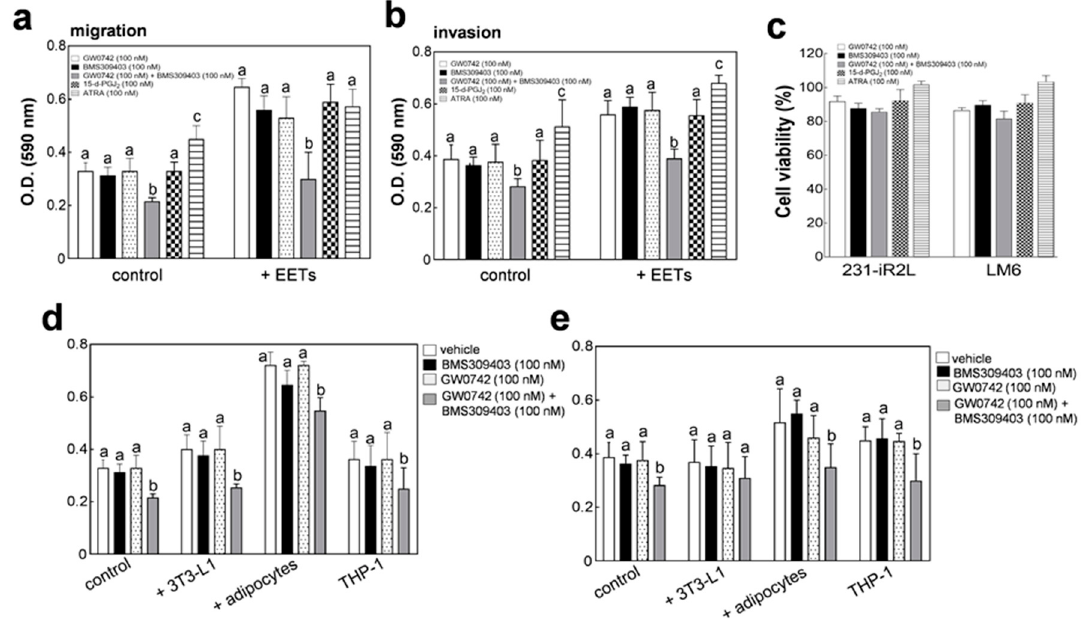
Figure 6. Dual regulation is necessary to abolish expression of FABP4 and FABP5 induced by EET- supplementation or co-culture of metastatic TNBC cells with stromal cells. Effects of a FABP4 inhibitor (BMS309403), a pan-PPAR antagonist (GW0742), an FABP5/PPAR- γ agonist all-trans retinoic